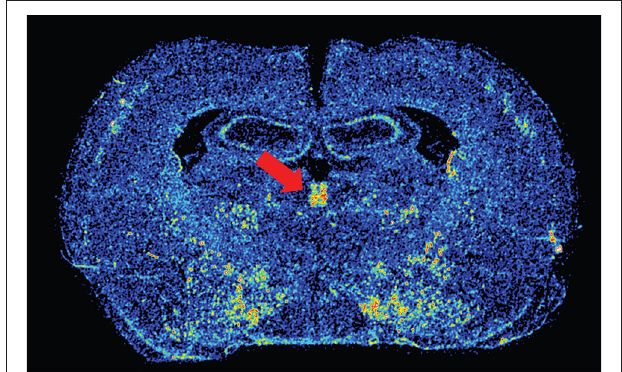
FIGURE 1 | Image of dopamine D3 receptor mRNA expression. Color-enhanced in situ hybridization image of D3 mRNA in the PVT (red arrow) in a coronal rat brain section. Approximate Bregma level is –2.28 (Paxinos and Watson,